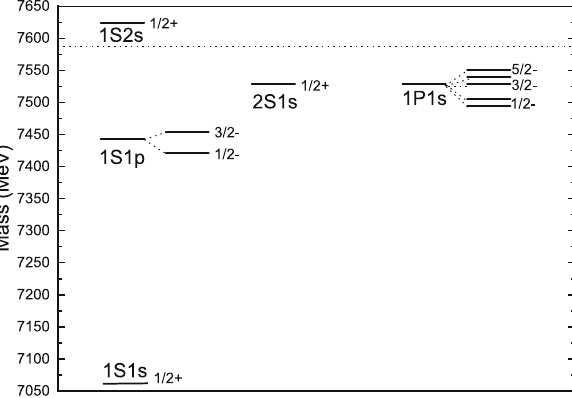
Fig. 8 Mass spectrum (in MeV) of (cid:3) (cid:2) baryons, corresponding to the bc Table 16. The horizontal dashed line shows the (cid:4) b D s